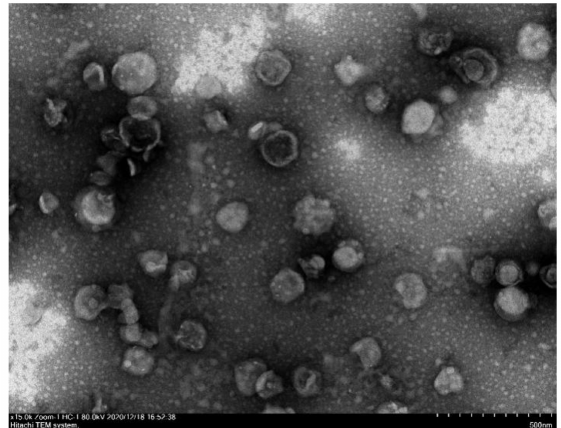
Figure 4. TEM image of compound 4d